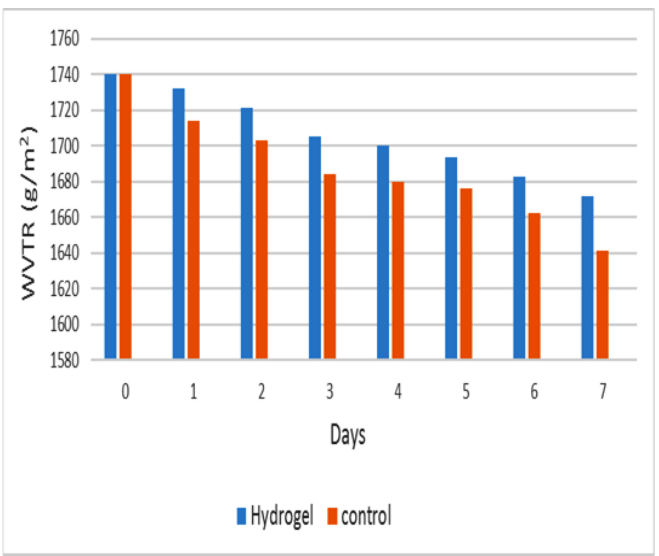
Figure 6. Water vapor transfer rate of hydrogel.